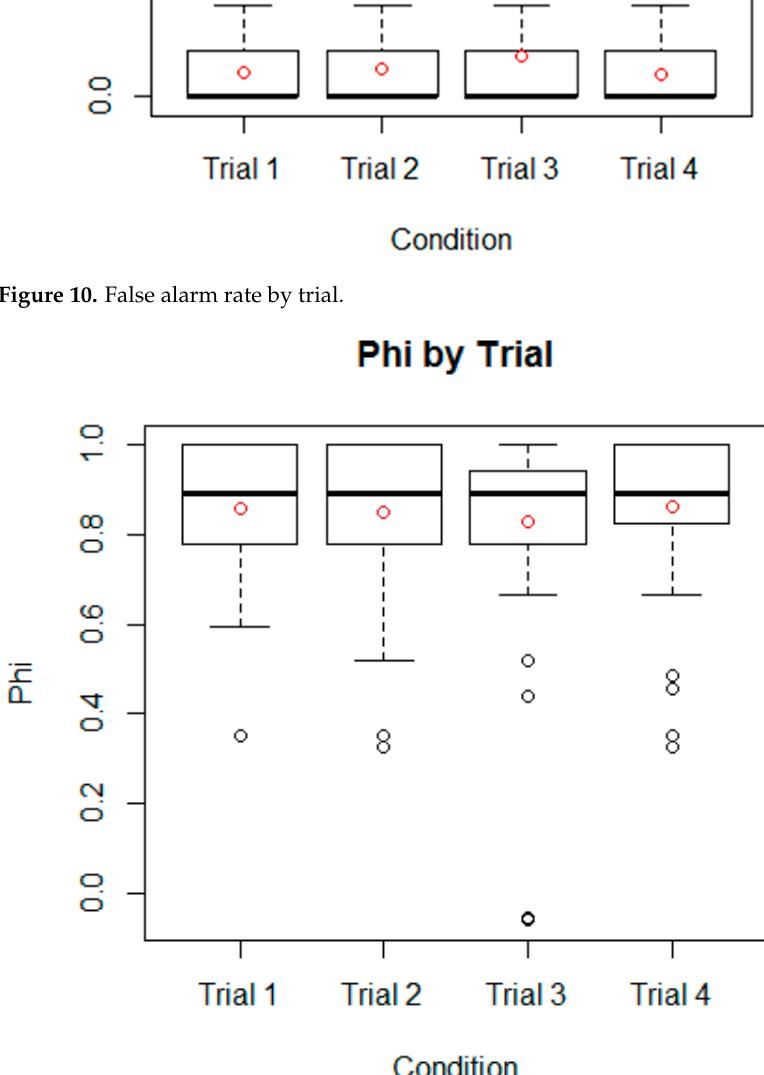
Figure 11. Matthews correlation coefficient (Phi) by trial.